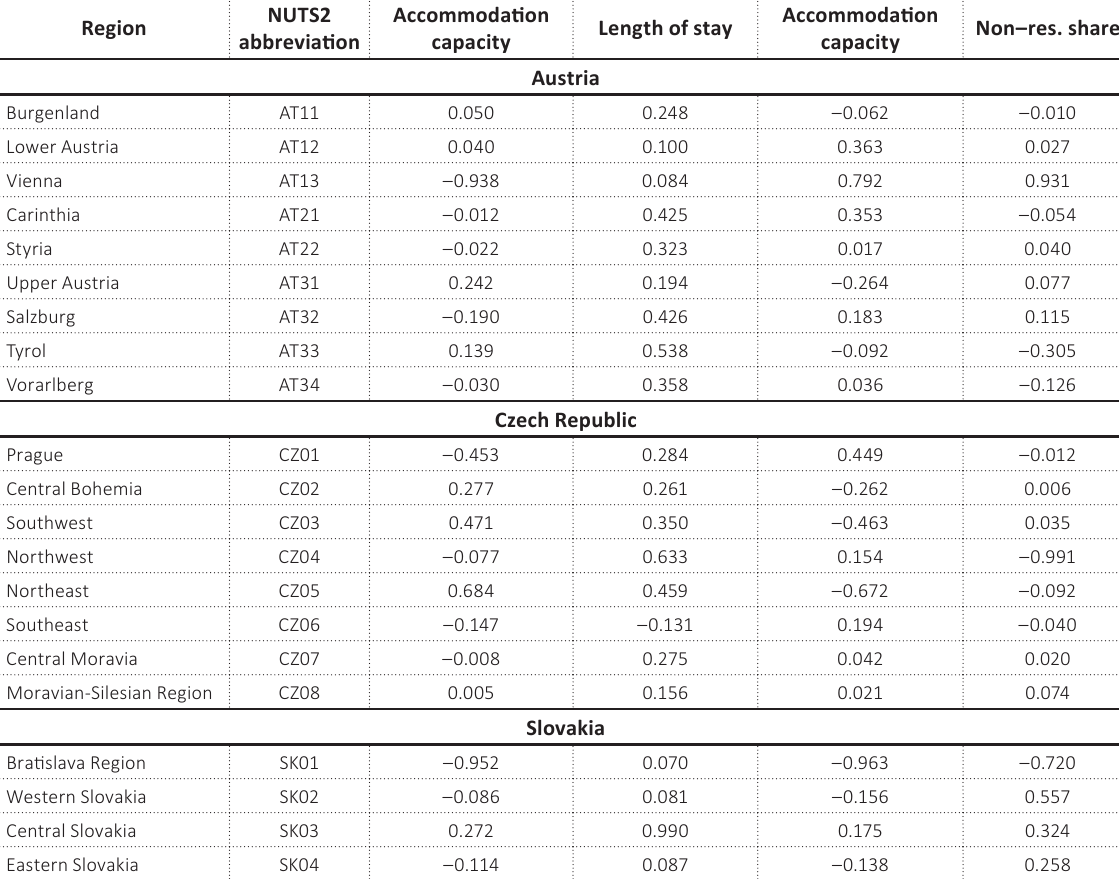
Table 5. Selected Central European countries for PLS coefficients of capacity vs. length of stay and non-residents share